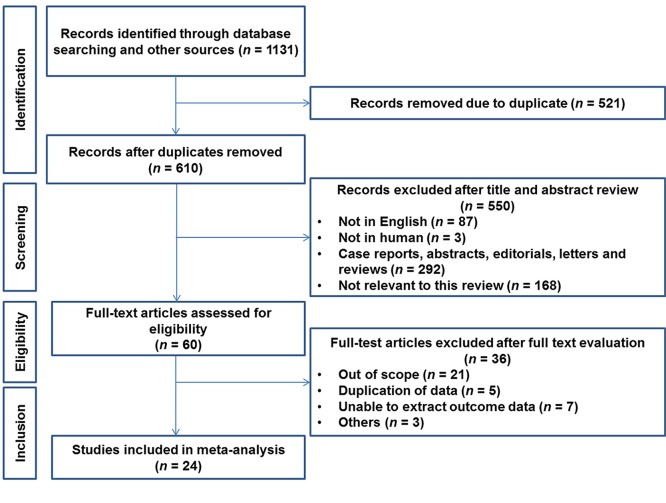
PRISMA statement flow diagram showing the search strategy for meta-analysis.